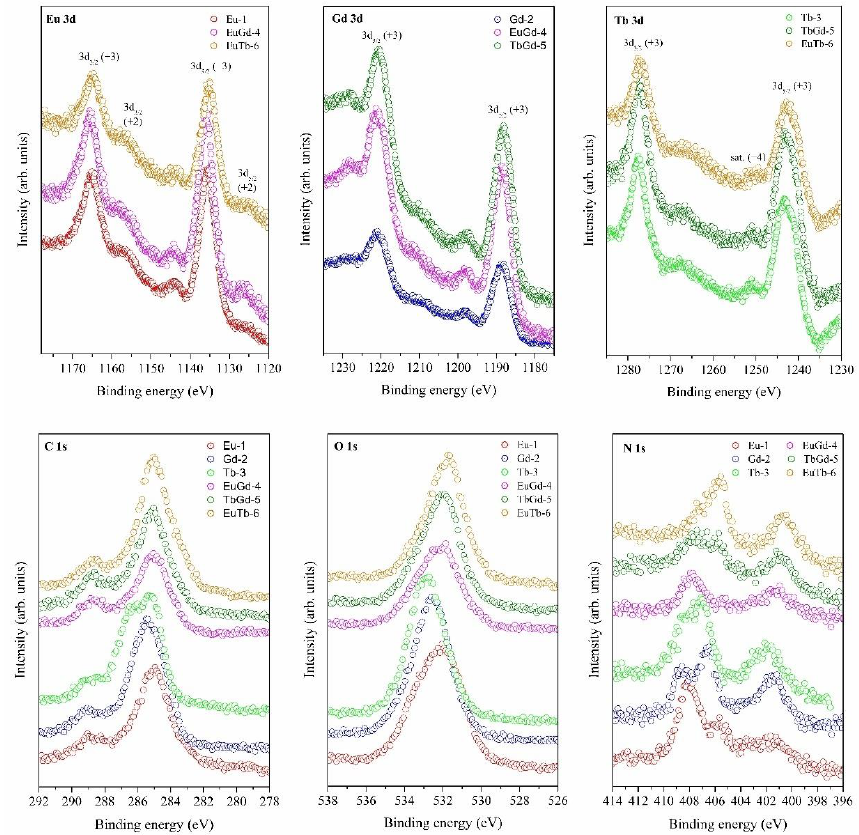
Figure 2. HR XPS spectra of the Eu 3d, Gd 3d, Tb 3d, C 1s, O 1s and N 1s of [Ln(btc)] (Eu-1, Gd-2, Tb-3, EuGd-4, TbGd-5 and EuTb-6) powders. The XPS core-level spectra of the O 1s, C 1s and N 1s of Eu-1 and EuTb-6 are shown in Figure 3. The total atomic percentage concentrations of C, O and N in the EuTb-6 powder on the surface were determined to be 53.7, 33.8 and 8.7 %, respectively. The C 1s peak for EuTb-6 can be sectioned into three peaks at 285.0, 286.8 and 288.9 eV, which were assigned to C-H, C-C (35.4 at.%), C-O, C-O-H (8.2 at.%) and C=O. C-O-C (10.1 at.%), respectively [32,33]. The O 1s peak can be composed of three peaks at 531.3, 531.8 and 533.1 eV, which were ascribed to C-O (8.8 at.%), H-C-O (17.2 at.%) and O-H, with Ln-C-O (7.8 at.%) bindings of EuTb-6 [33,34]. The N 1s peak of the EuTb-6 sample, as shown in Figure 3, contains three peaks assigned to the subsequent bands: 400.6 eV (N-H-N-O, C-H-OH), 405.6 eV (N-O), and 407.2 eV (O-N-C-H) [34,35]. The XPS results for C 1s and N 1s are in good agreement with the FTIR ν (C=O) and δ (O=C-N) from coordinated DMF, respectively.